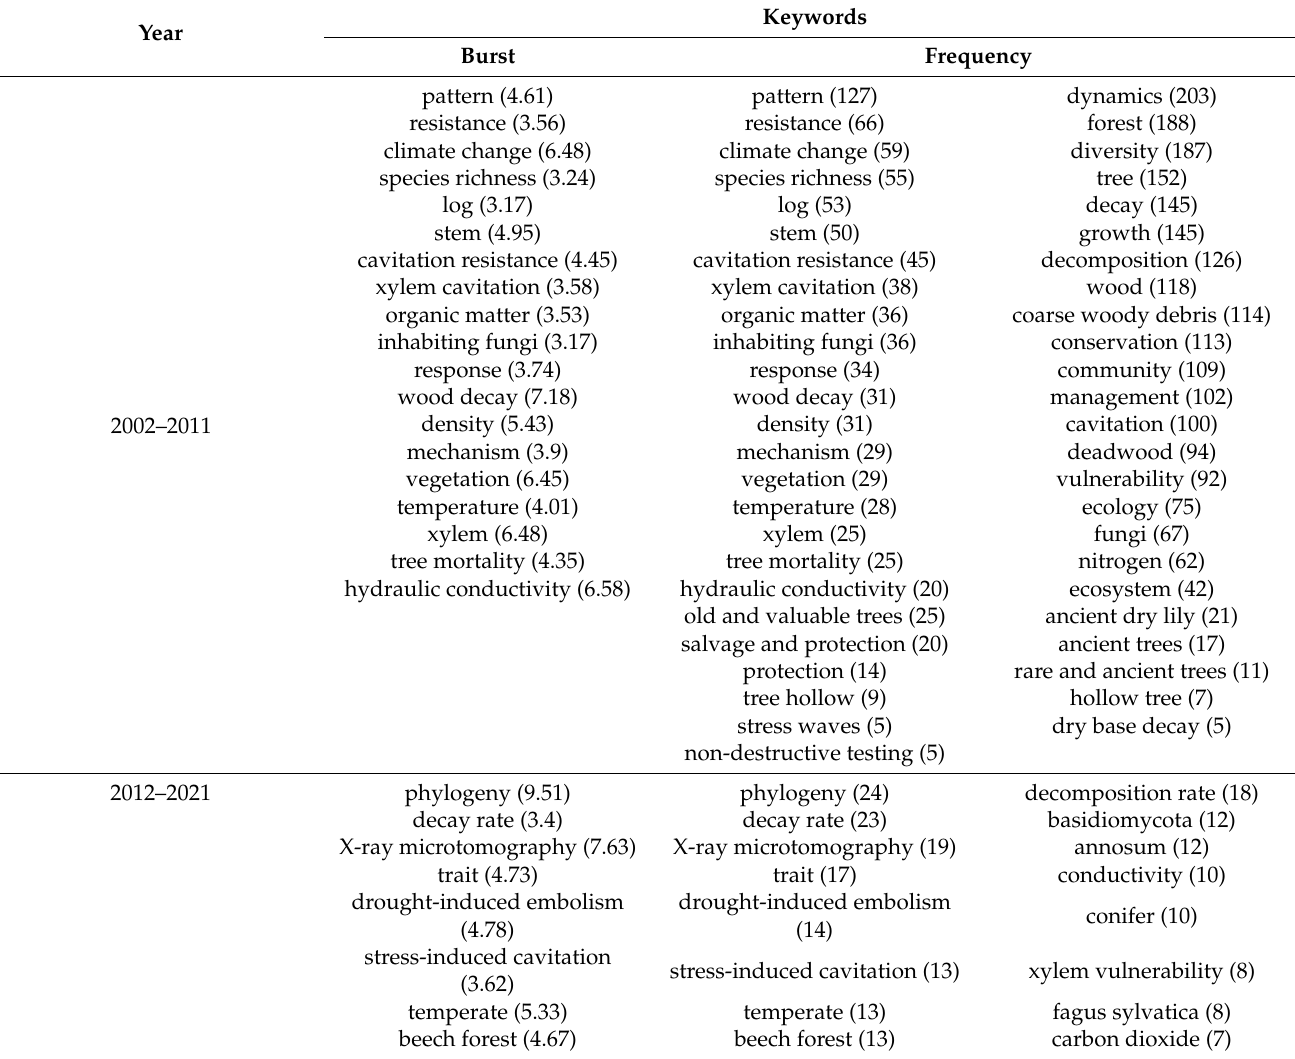
Figure 3. The time-zone evolution map of hot keywords. Figure 3. The time ‐ zone evolution map of hot keywords. Table 1. The information of high frequency and burst Table 1. The information of high frequency and burst keywords.